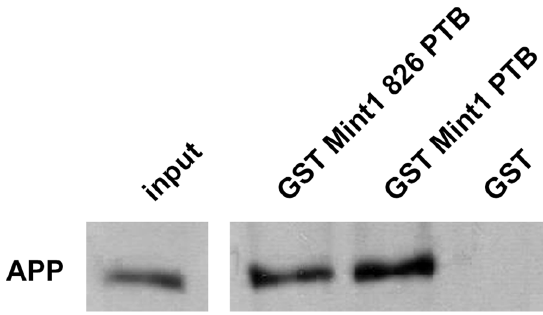
Figure 7. Verification of the interaction between Mint1 826 and APP. 10 m l of Glutathione Sepharose TM 4B beads were coated with 5 m g of GST or the denoted GST Mint1 fusion proteins and then incubated with MEF dko APP695 AA12 cell lysates (20 x input) for 1.5 h at 4 u C. Samples were analyzed by Western blotting using an anti-APP C- terminus antibody.